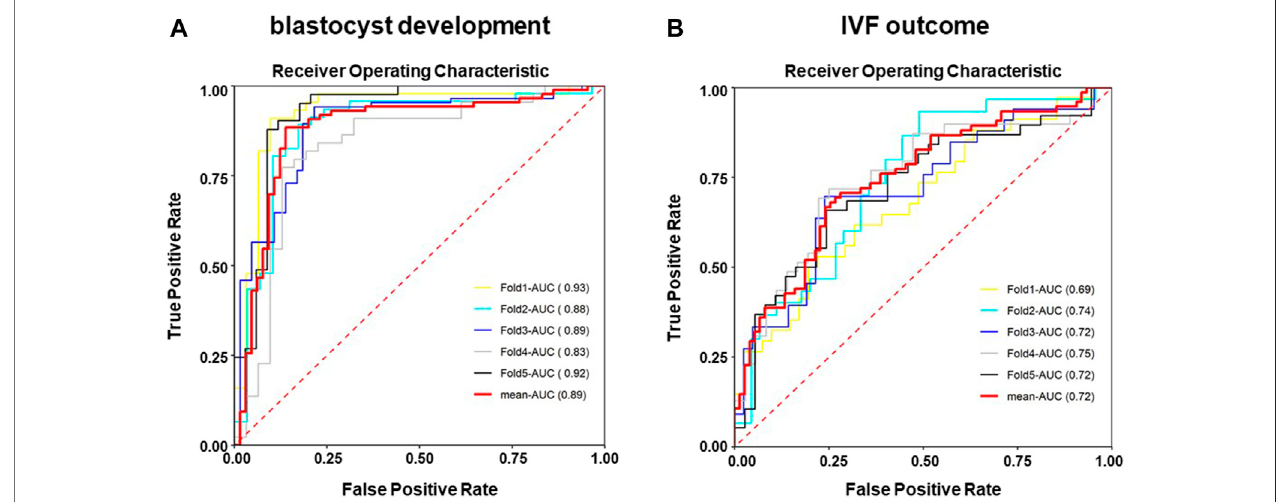
FIGURE 8 | Receiver operating characteristic (ROC) curves of the ANN classi fi cation models after randomizing the sample data set. The performance of the establishedmodel wasevaluatedbythe areaunder thereceiveroperating characteristic (ROC) curve(AUC)basedon a fi ve-foldcross-validation strategy, whichdivided the data into fi ve parts, training four parts in turn, and the remaining was used to estimate the performance of the models. (A) ROC analysis of the ANN model for classifying the blastocyst developmental potential. (B) ROC analysis of the ANN model for classifying the IVF outcome.